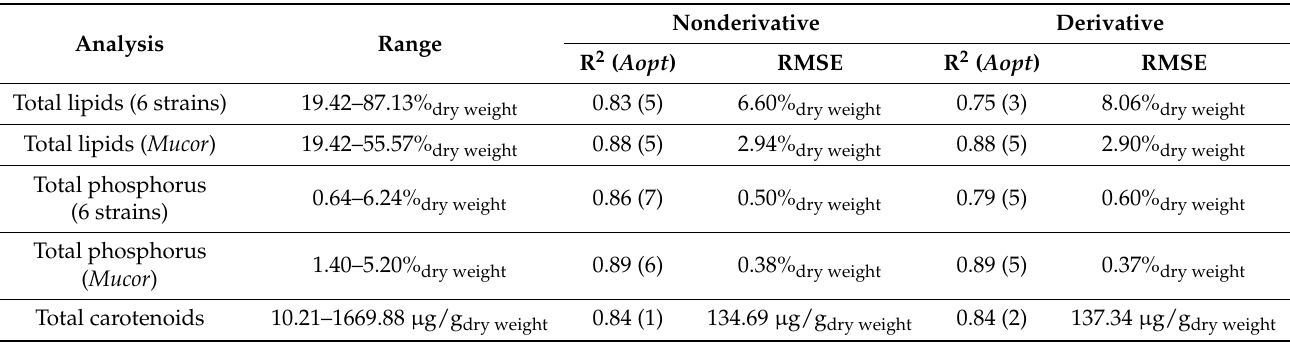
Table 2. PLSR coefficients of determination (R 2 ) and root mean square errors (RMSE) for determination of total lipids, phosphorus, and carotenoids, with the number of components in parenthesis ( Aopt ), for the regression analyses based on nonderivative and derivative preprocessed FT-Raman data.